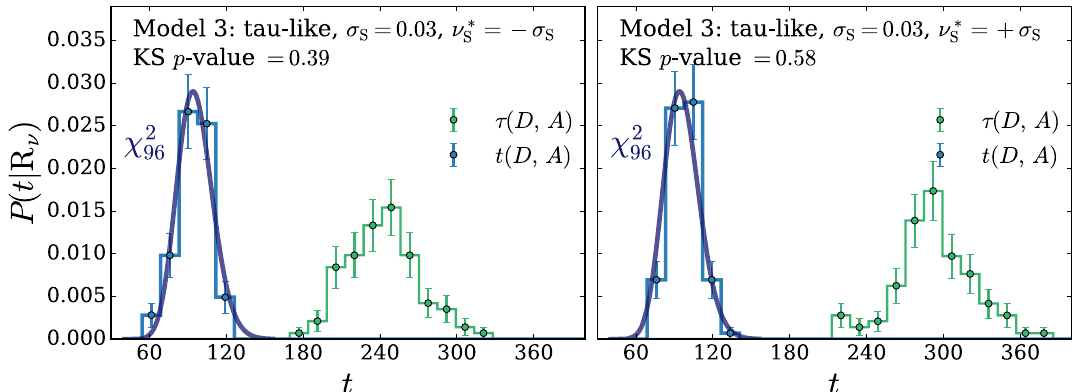
Fig. 19 The empirical distribution of τ (in green) and of t (in blue) computed by 100 toy experiments performed for Model 3 in the R ν hypothesis at ν s = − 1 (left side) and ν s = + 1 (right side) for the τ -like regime before enriching the reference sample in the region of high transverse momentum